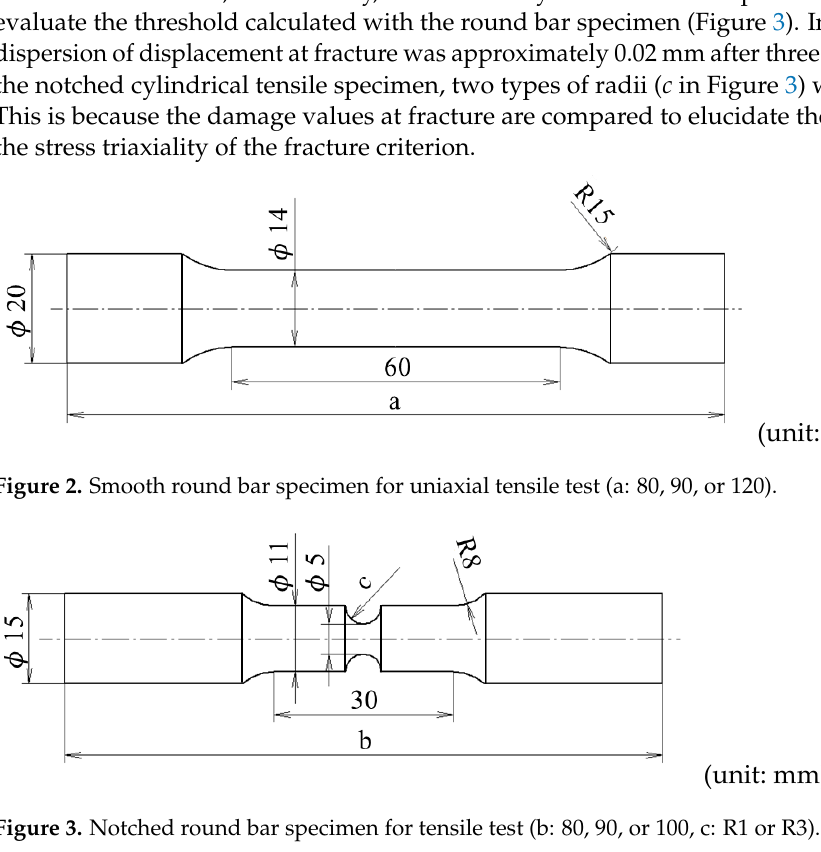
Figure 1. Calculation flow chart of damage equation considering compressive stress.